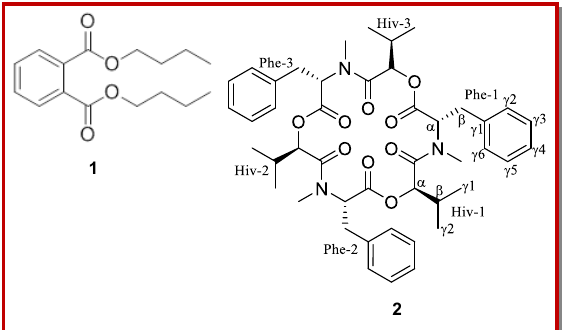
Figure 4: Chemical structures of antimicrobial compounds 1 and 2 from strain